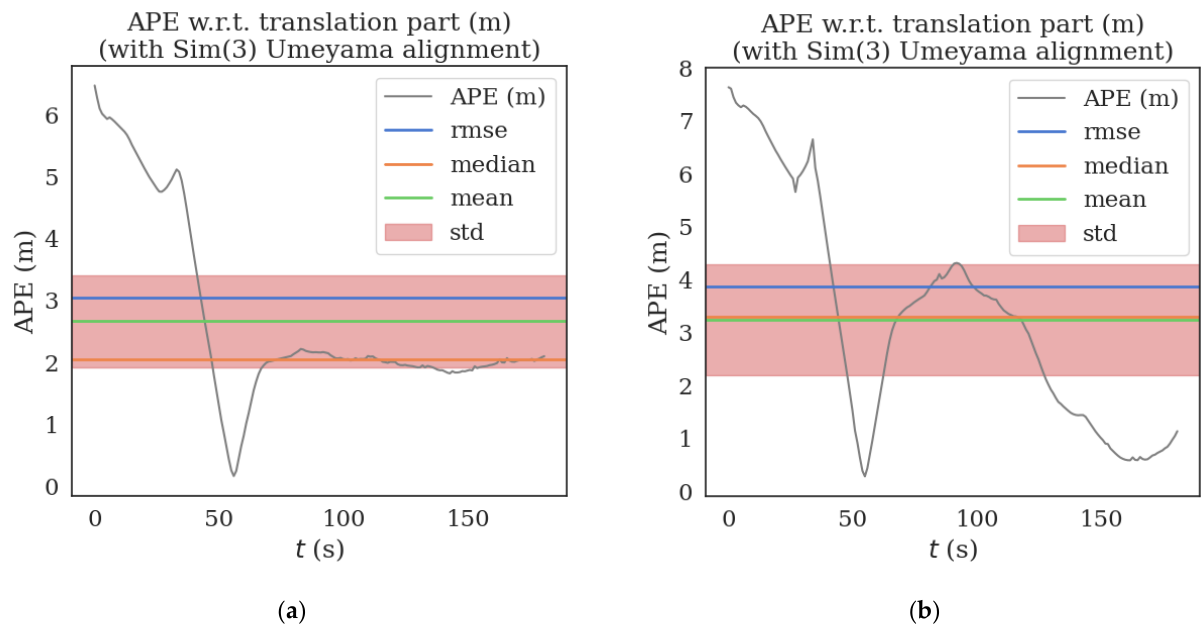
Figure 10. ( a ) is the Absolute Pose Error (APE) of the improved algorithm and ( b ) is the Absolute Pose Error (APE) of the original algorithm. The black line is the absolute pose error (APE), the blue line is the root mean square error (RMSE), the orange line is the median error (median), the green line is the mean error(mean), and the red area is the standard deviation (std).